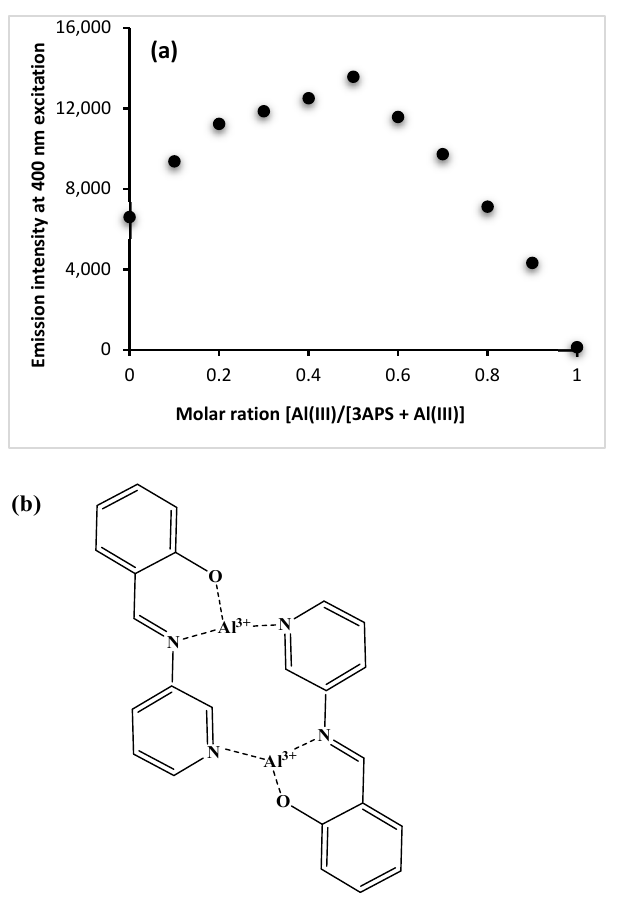
Figure 9. Job’s plot of the 3APS–Al(III) system ( a ). The proposed structure of the 3APS–Al(III) complex ( b ).